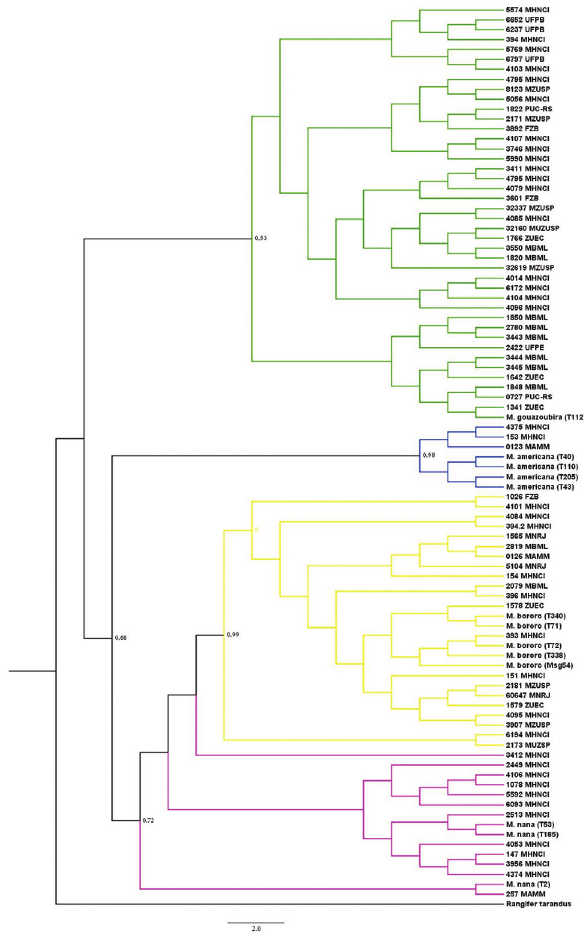
Figure 2 - Phylogenetic tree inferred from Bayesian analysis, demonstrat- ing the relationships between recent DNA samples and museum collec- tions within the genus Mazama , identified by a fragment of the mitochon- drial Cytb . Reference samples are represented by the species name and identification code. Museum specimens are represented by their registra- tion number and museum acronym. The colours indicate the four species identified in the museum specimens ( M. americana , blue; M. nana , pink; M. bororo , yellow; M. gouazoubira ,